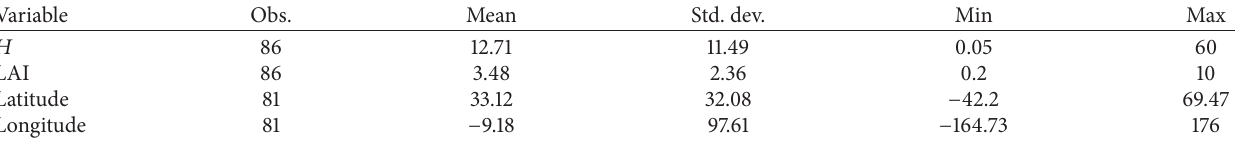
Table 1: Descriptive statistics of the dataset at 86 site-years of field measurements from sites worldwide.